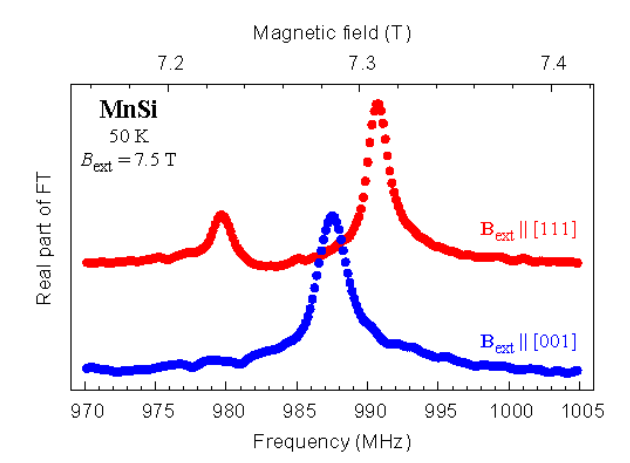
Figure 4. Fourier transform of transverse-field (TF)- µ SR spectra recorded with the Czochralski crystals at 50 K and B ext = 7.5 T. The field is either set along the [111] or [001] crystal